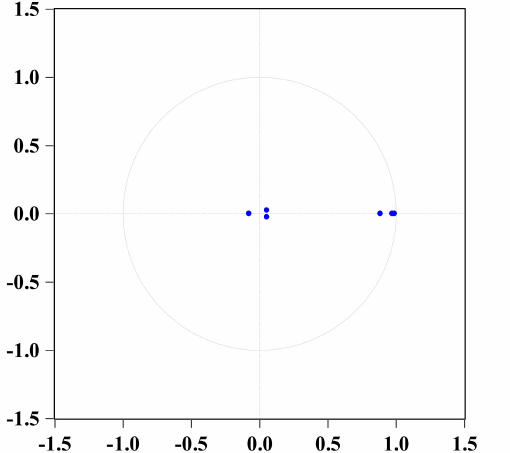
Figure 2. The inverse roots of the AR characteristic polynomial. Note: Blue bullet represents unit root, all blue bullets are inside the unit circle, which means that all unit roots are inside the unit circle.